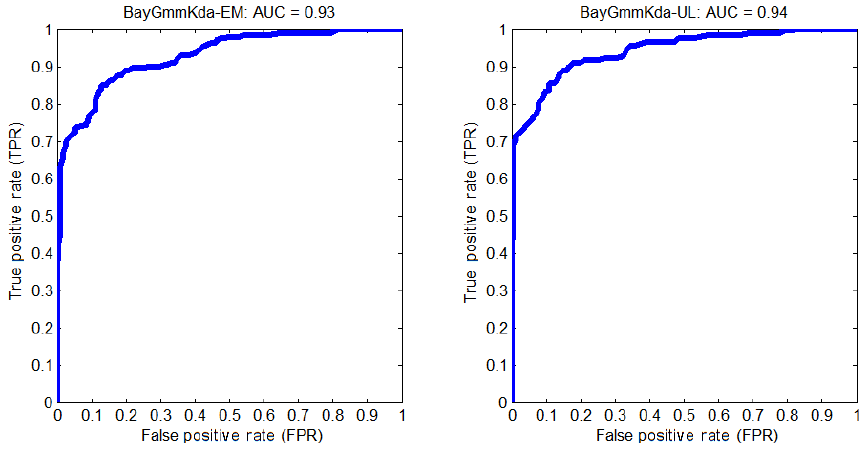
Figure 9. ROC plots of the proposed BayGmmKda.